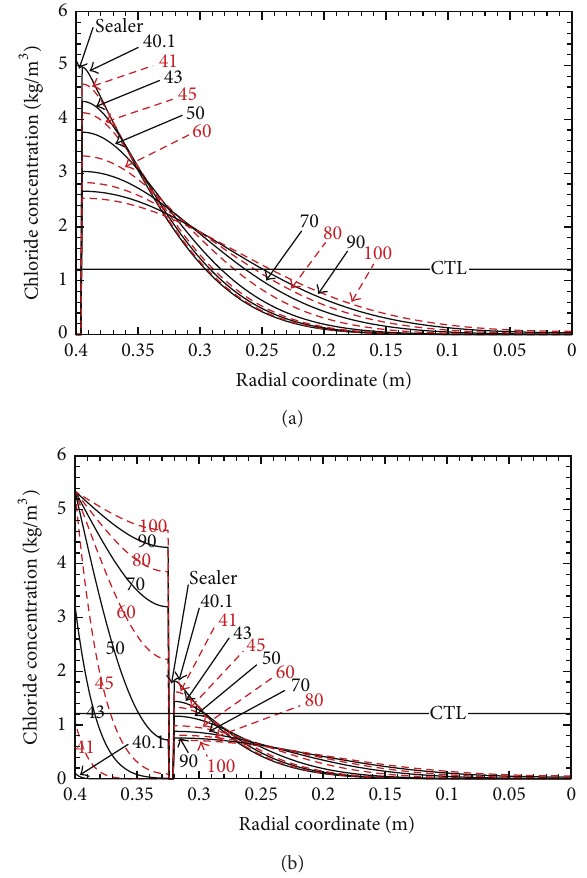
Figure 7: The spatial distribution of chloride concentration for 10 exposure scales, extracted from (a) Figure 6 and (b) Figure 9. Also plotted in each of the two figures is the CTL (1.2 kg/m 3 ) required for corrosion